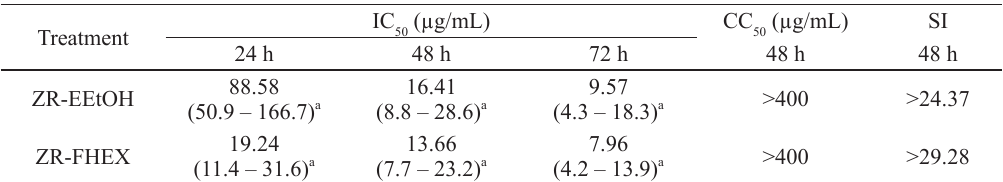
) and mean cytotoxic concentration (cc 50 of L. amazonensis